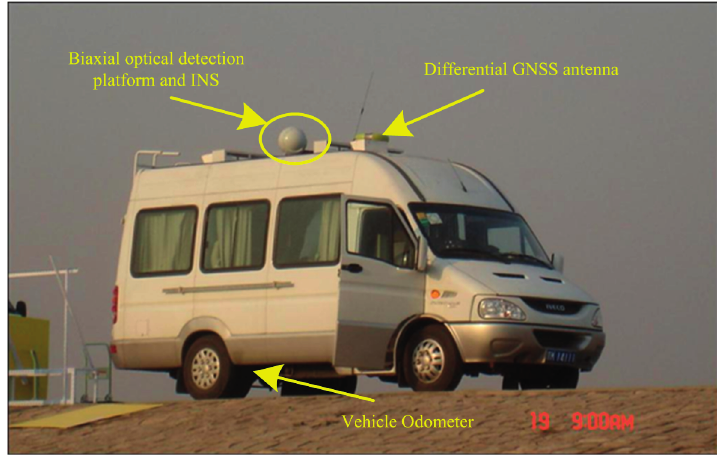
Figure 10. Experimental vehicle and relative